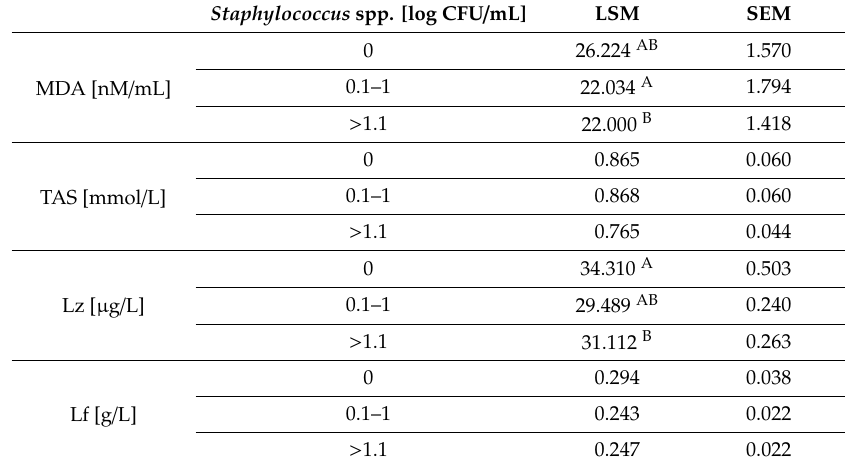
Table 3. Association of Staphylococcus spp. with changes in whey proteins, MDA and TAS content.